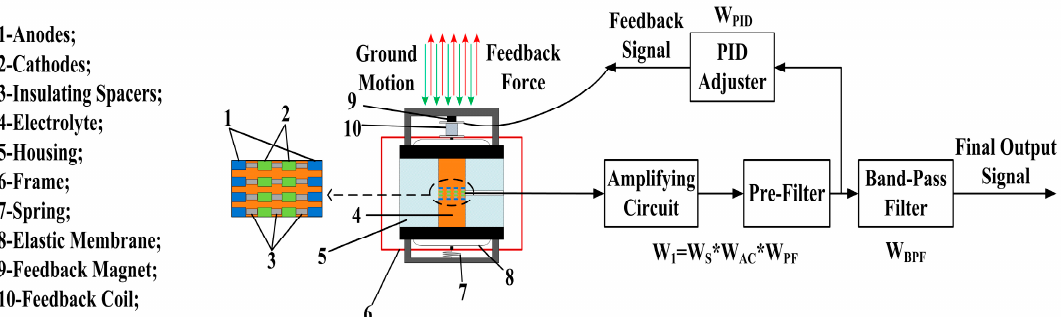
Figure 1. The schematic of the MEMS electrochemical seismic sensor which is composed of a sensing unit including porous sensing electrodes immersed in an electrolyte solution sealed in a plexiglass house by elastic membranes and a feedback unit including a feedback circuit, a feedback magnet, and a feedback coil. In response to external seismic signals, the electrolyte moves opposite to the direction of the external vibration, leading to ion concentration gradients and raw current outputs between the anode–cathode pairs. The raw output signals generated from the sensing unit were processed by the feedback circuit and then applied to the feedback coil, generating feedback forces due to its interactions with the feedback magnet, counterbalancing the movement of the liquid mass.